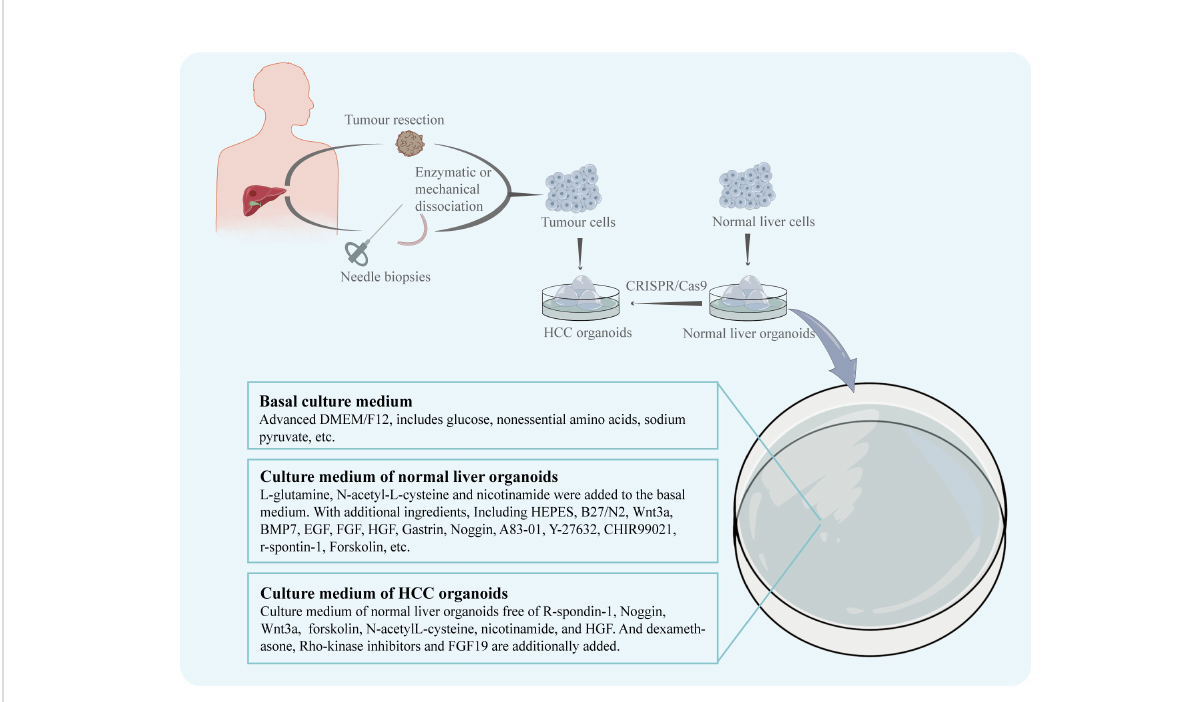
FIGURE 1 The patient's HCC tissue, obtained by intraoperative resection or needle biopsy, is enzymatically or mechanically broken down to obtain dispersed tumour cells. The tumour cells are cultured in dishes to obtain the HCC organoids. Normal hepatocytes from other sources are cultured in dishes to obtain normal liver organoids. The CRISPR/Cas9 system can be used to induce the generation of HCC organoids. The nutrient solution used for culture was adjusted according to the growth characteristics of